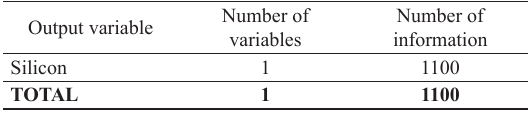
Table 2. Output variable.